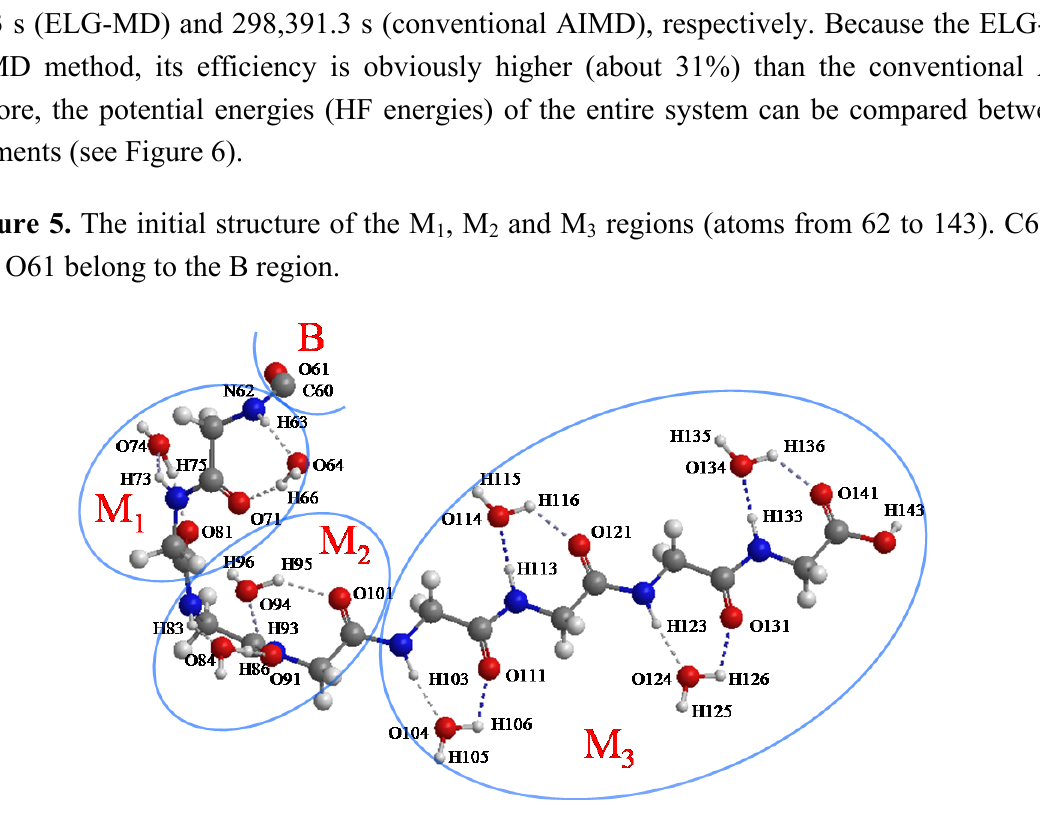
with 14 water molecules 14